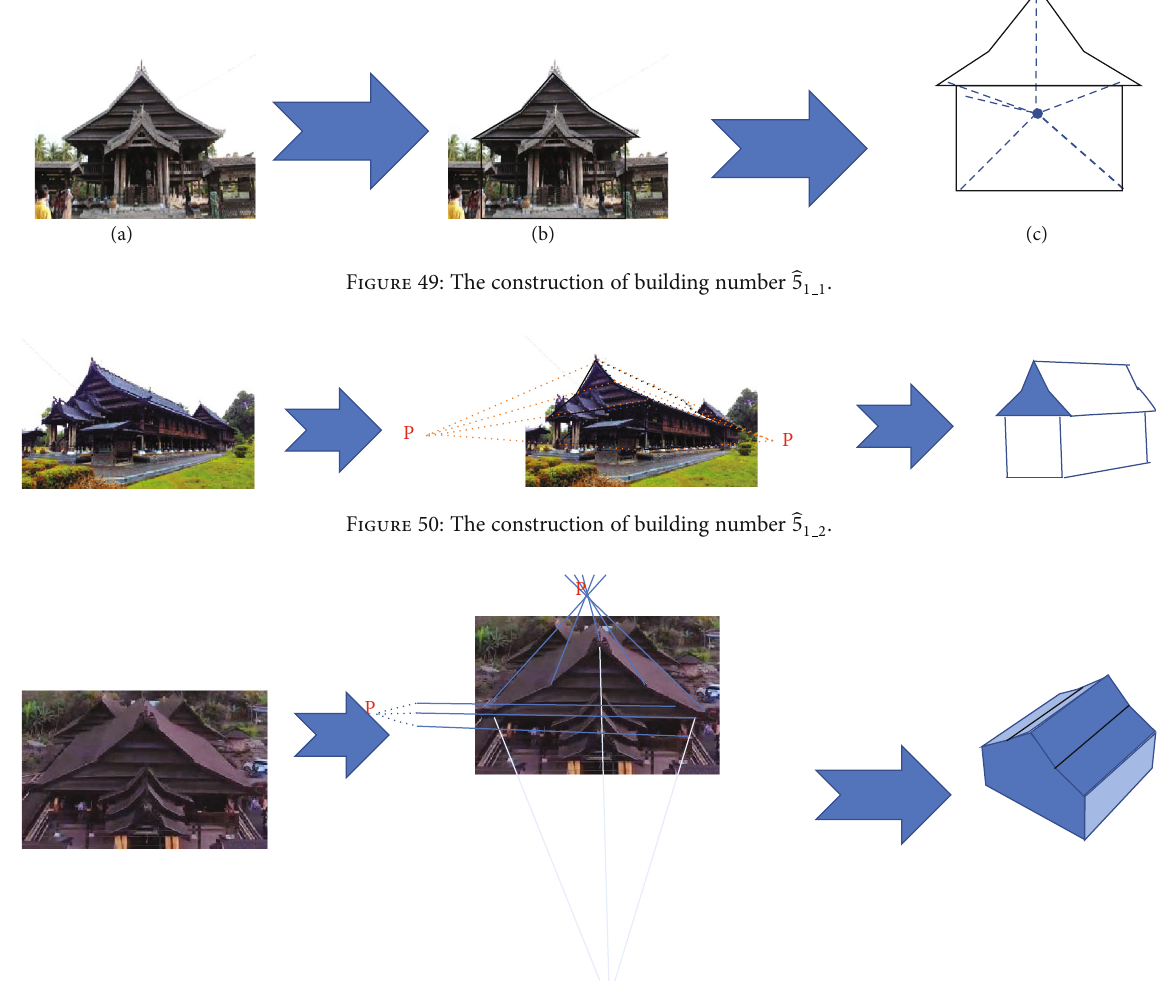
Figure 51: The construction of building number b 5